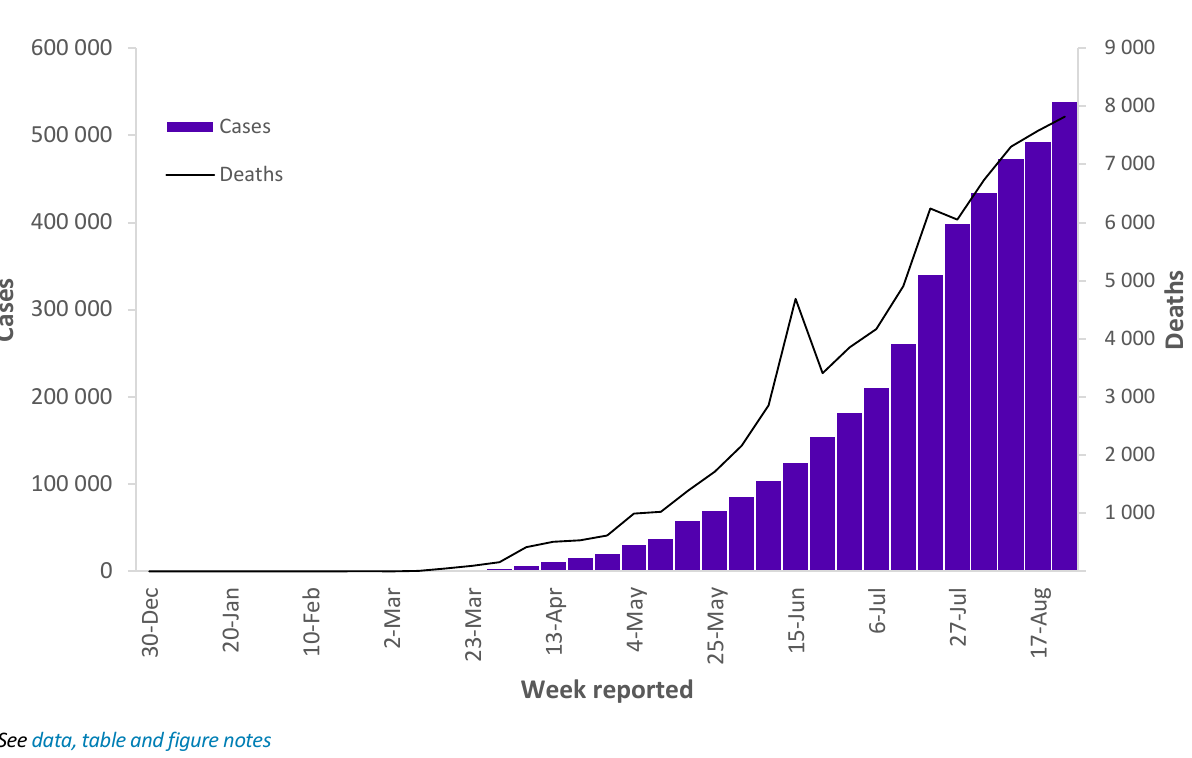
Figure 7: Number of COVID-19 cases and deaths reported weekly by South-East Asia Region, data as of